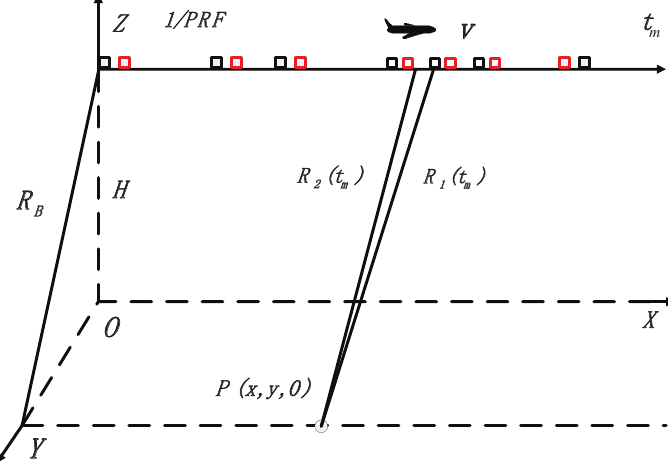
Figure 3. Random sampling mode in the azimuth